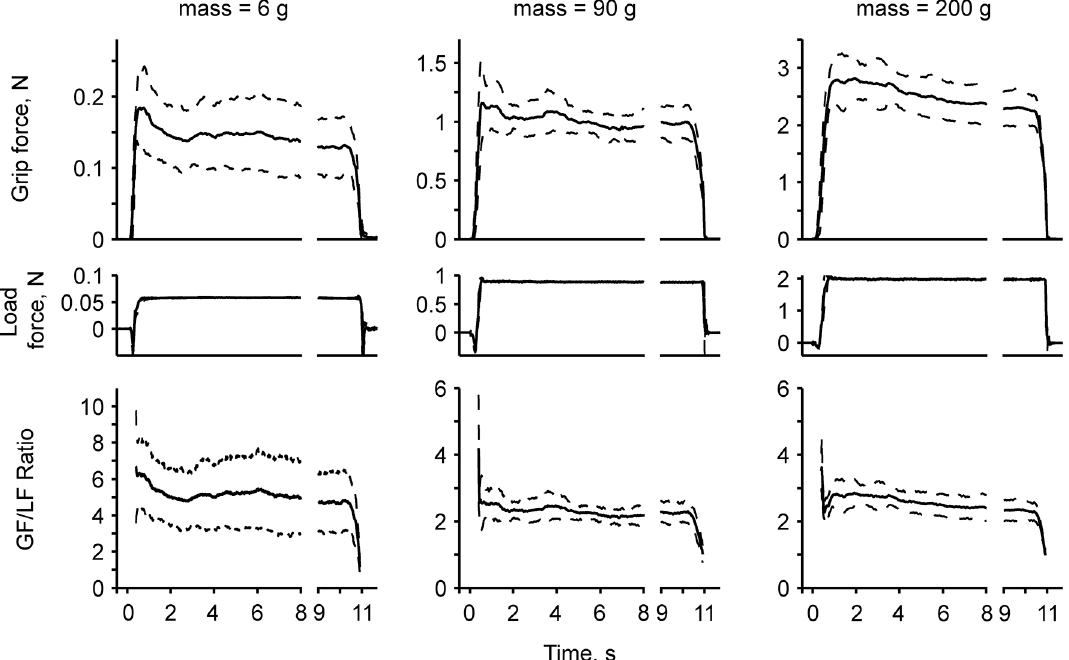
Fig 2. Typical force-time history curves of grip and load forces during the lift-hold task performed by one subject. The data are the mean (solid lines) ± standard deviation (dashed lines) of 8 trials for the 6, 90, and 200 g mass conditions with the rayon grip